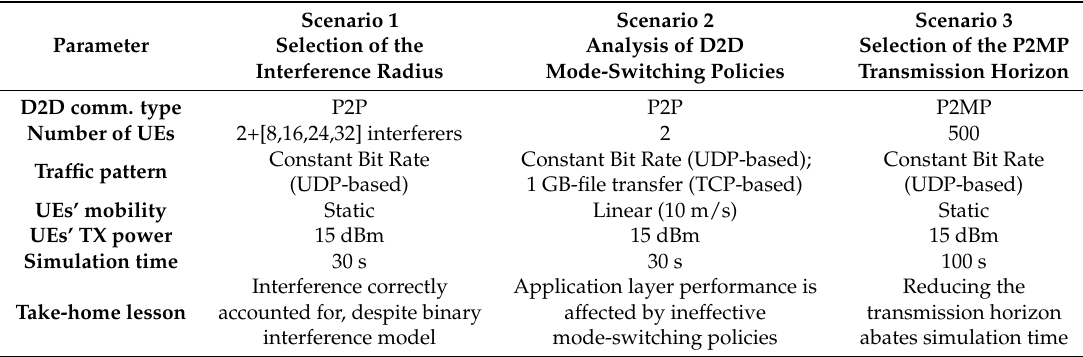
Figure 20. SINR perceived with different interference radiuses. Table 4. Summary of main simulation parameters.